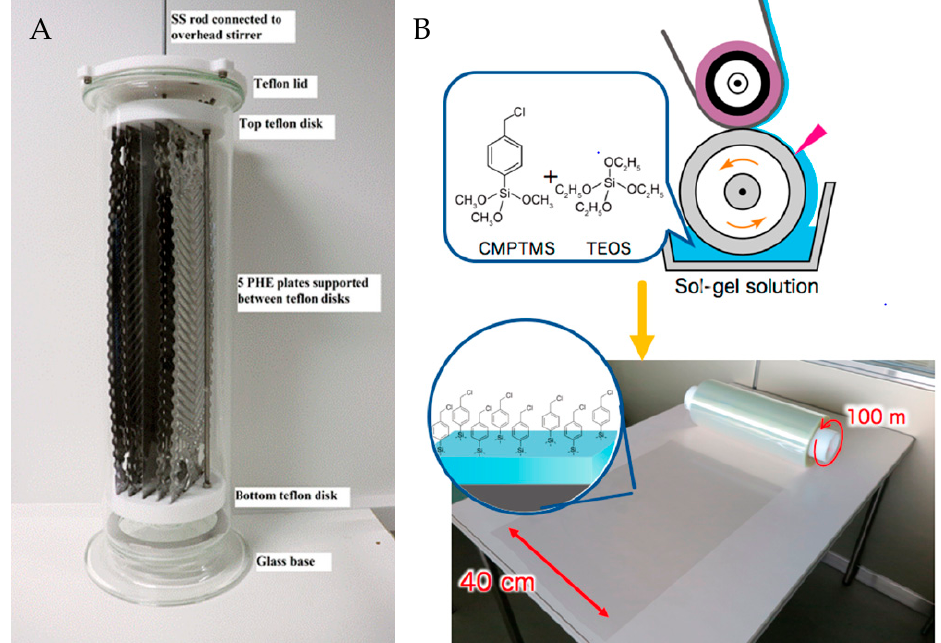
Figure 3. ( A ) Picture of the polymerization setup for the coating of commercial PHE plates. The PHE plates are supported by two teflon disks in a 10 L glass container with an overhead stirring bar, reprinted with permission from Friis et al. [53]. Copyright 2019 Elsevier. ( B ) Illustration of a roll-to-roll coating process on poly(ethylene terephthalate) (PET) film, reprinted with permission from Sato et al. [54]. copyright 2018 ACS.